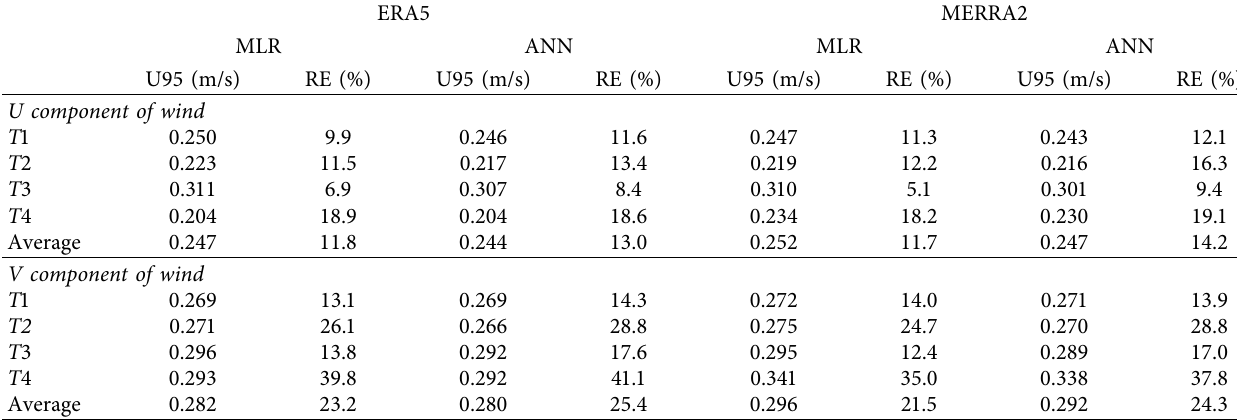
Table 5: Comparisons of the performance results for the U/V components of